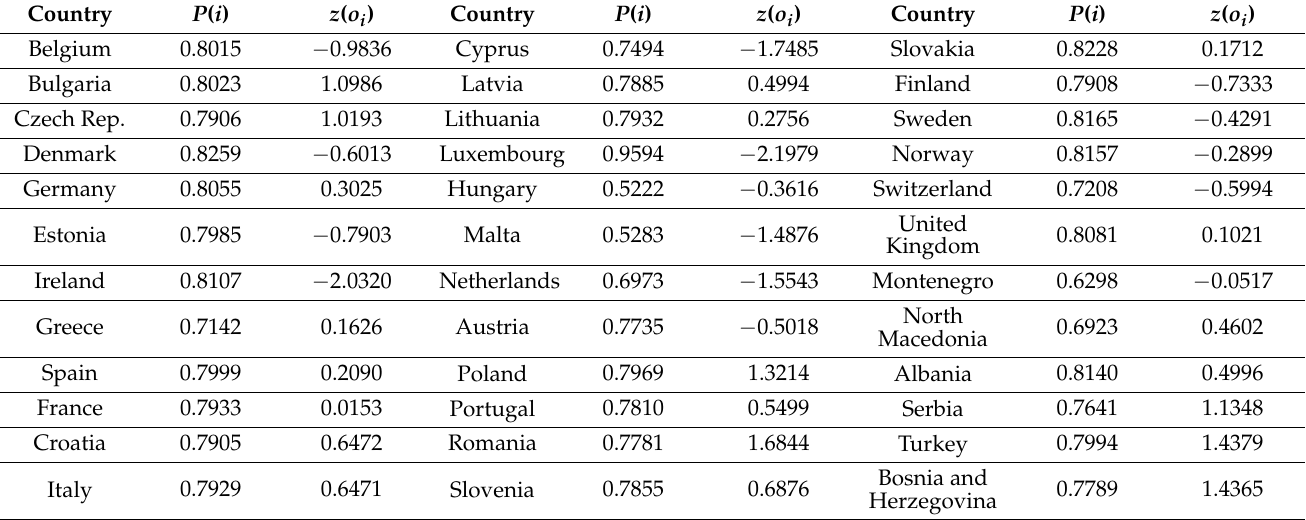
Figure 4. Plotting the multiplex participation coefficient 𝑃(𝑖) . Note: Using the Z -score of the total overlapping strength for each node yields a map of the responsibilities of nodes in a multilayer network. Even if two nodes have the same Z -score, their functions might change significantly depending on the value of the multiplex participation coefficient. Table 6 displays the multiplex participation coefficient and the corresponding Z -scores. Table 6. The multiplex participation coefficient 𝑃(𝑖) with Z -scores.